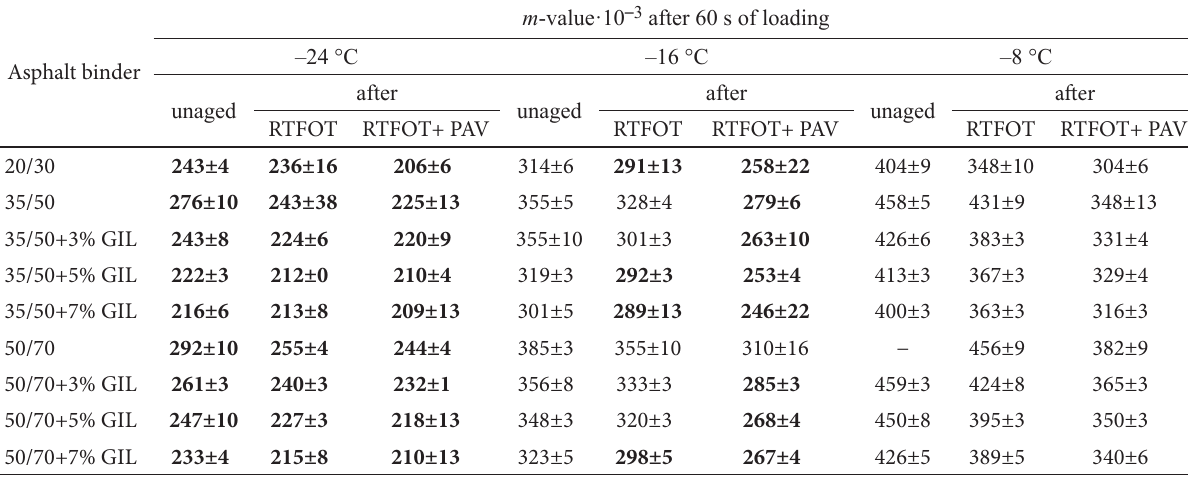
Table 5. Results of the m -value determination at –24 °C, –16 °C and –8 °C for the Gilsonite modified asphalt